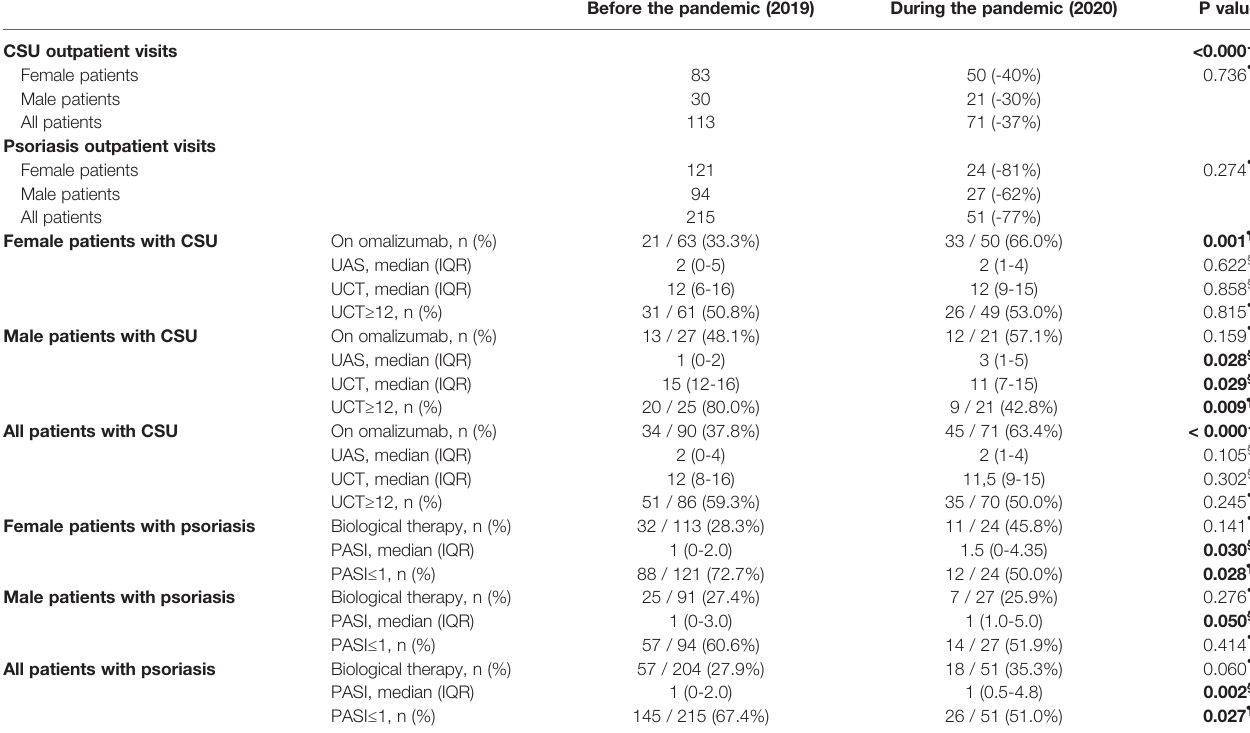
TABLE 1 | Number of outpatient visits, treatment and disease activity in female and male patients with psoriasis and CSU before and during the COVID-19